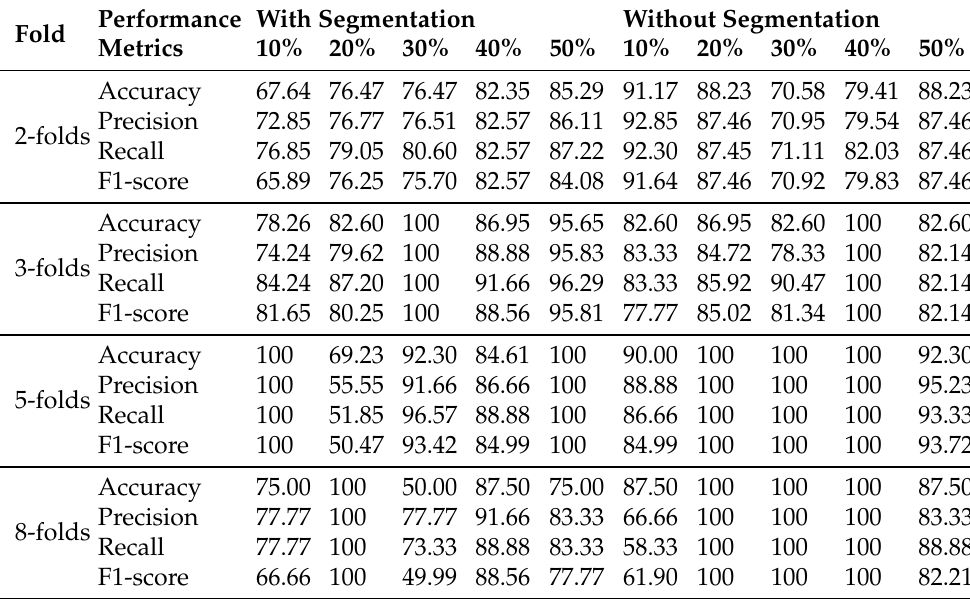
Table 6. Performance metrics for 10%, 20%, 30%, 40% and 50% testing data using Reference frame extraction for with and without segmentation for two, three, five, and eight folds.